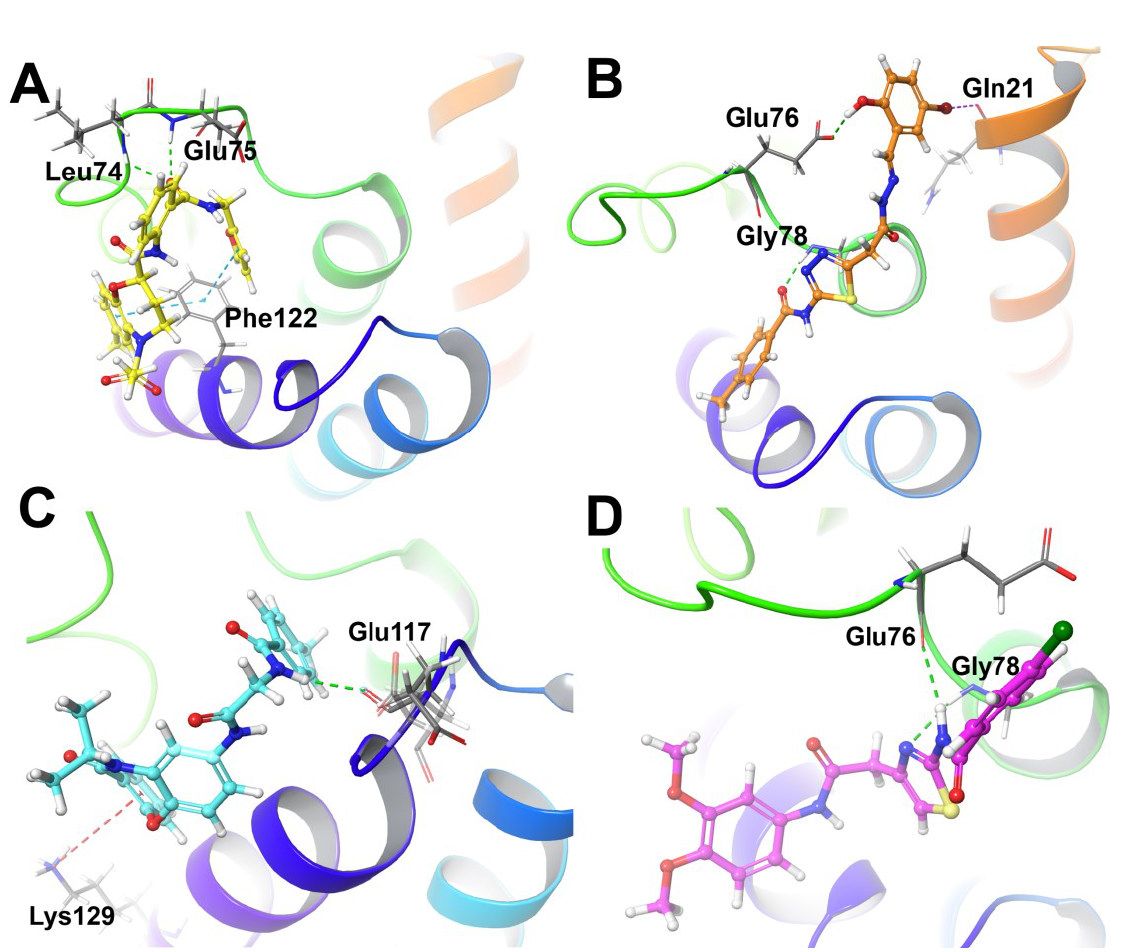
Figure 9. Interactions between the ligands and NusB: ( A ) J098-0498 ; ( B ) 1067-0401 ; ( C ) M013-0558 ; ( D ) F186-0261 .